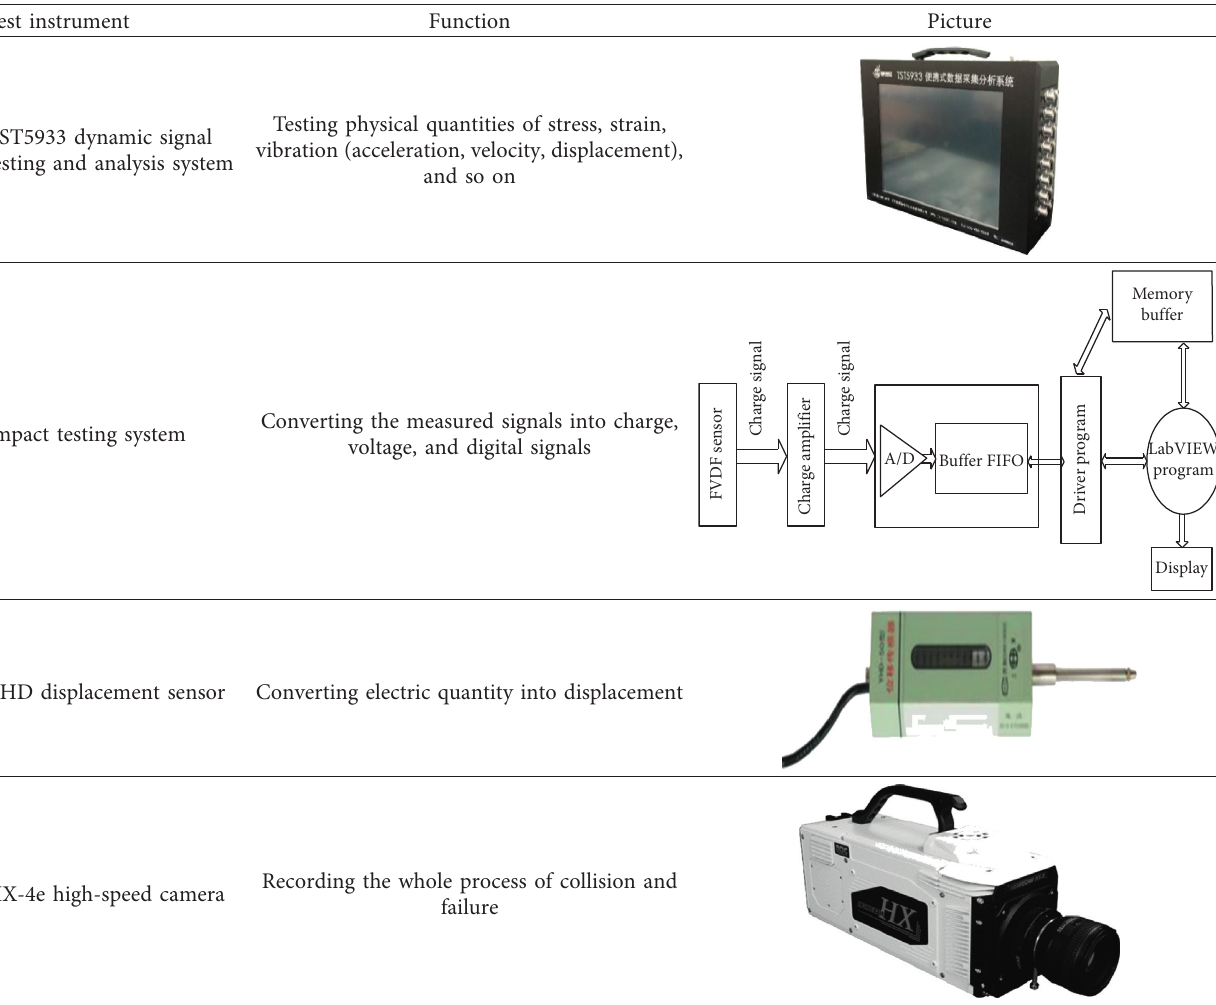
Table 3: Test instruments introduction.